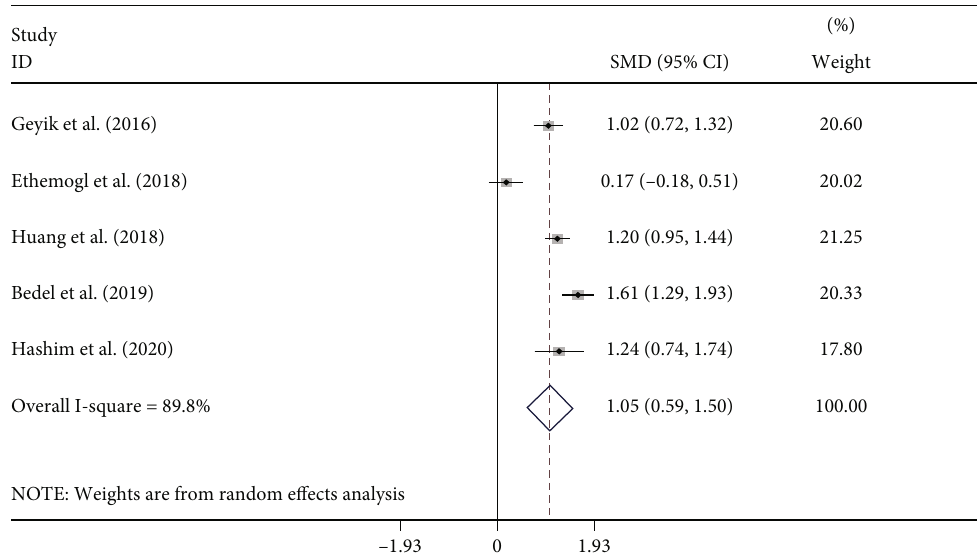
Figure 2: Meta-analysis of di ff erences in NLR levels between GBS patients before treatment and healthy controls.